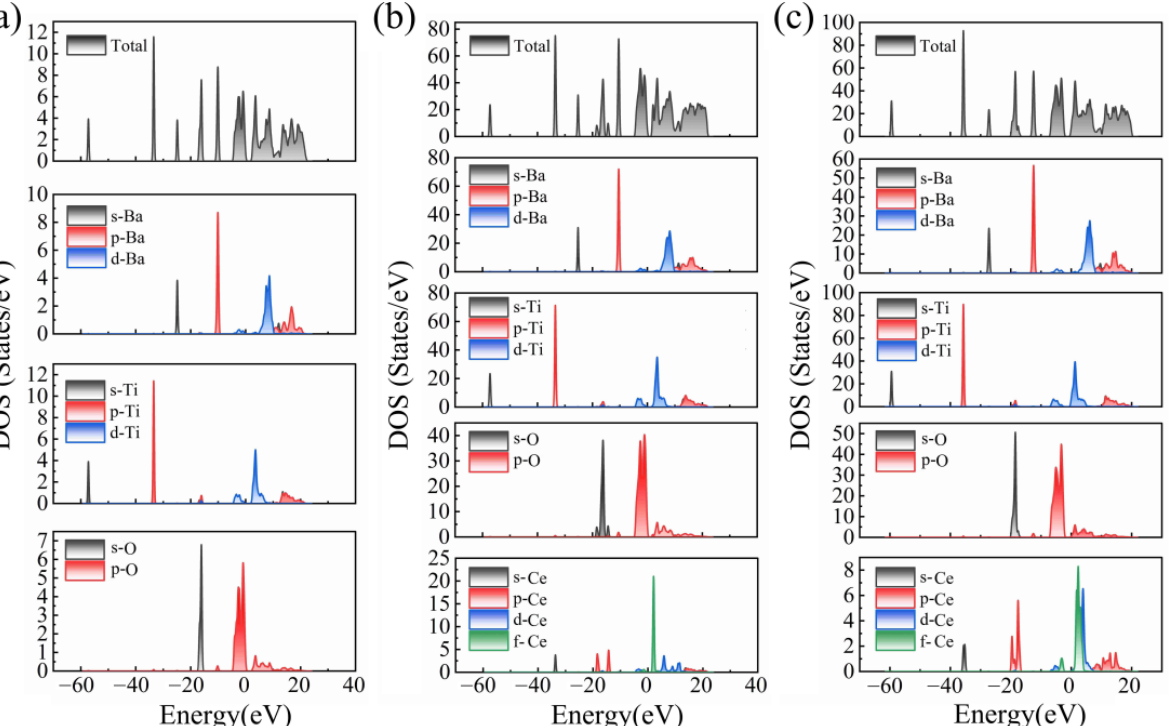
Figure 3. The total density of states and partial density of states of ( a ) BaTiO 3 , ( b ) Ba site substitution, and ( c ) Ti site substitution.